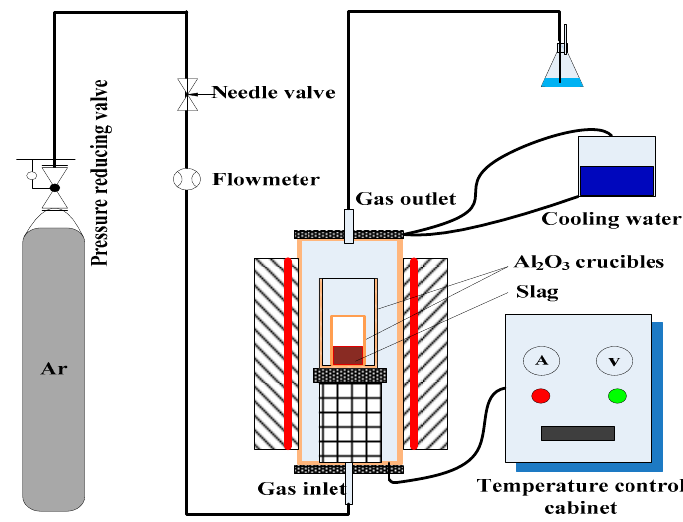
Figure 1. Schematic of the experimental equipment.